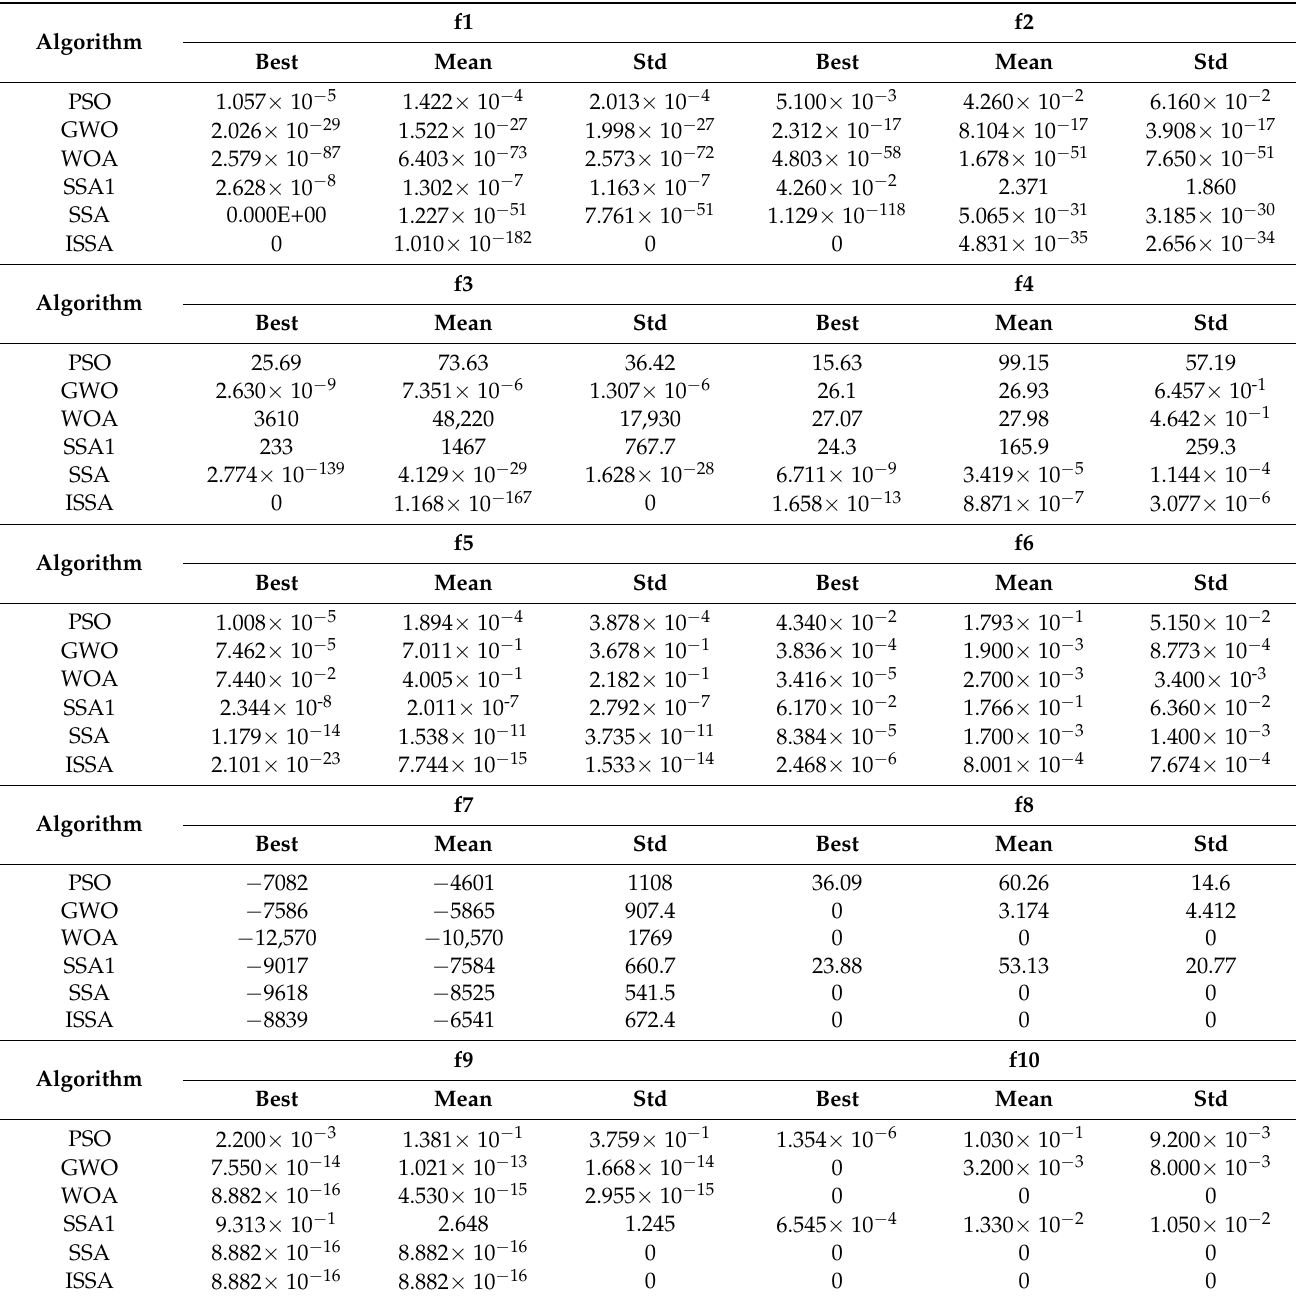
Table 3. Comparison of benchmark function